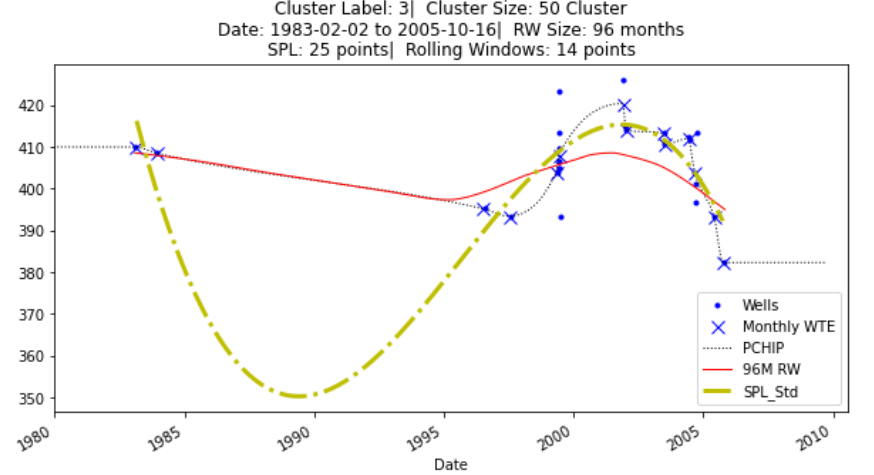
Figure 10. Temporal interpolation with PCHIP and 96-month window moving average and with the univariate spline.